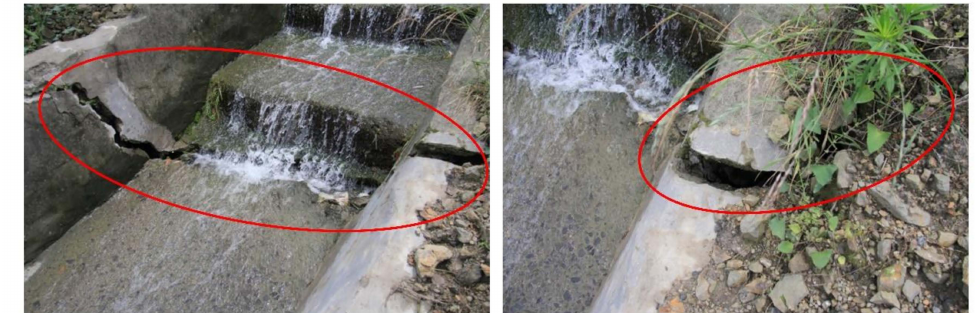
Figure 6. Deformation indications on the Shengjibao